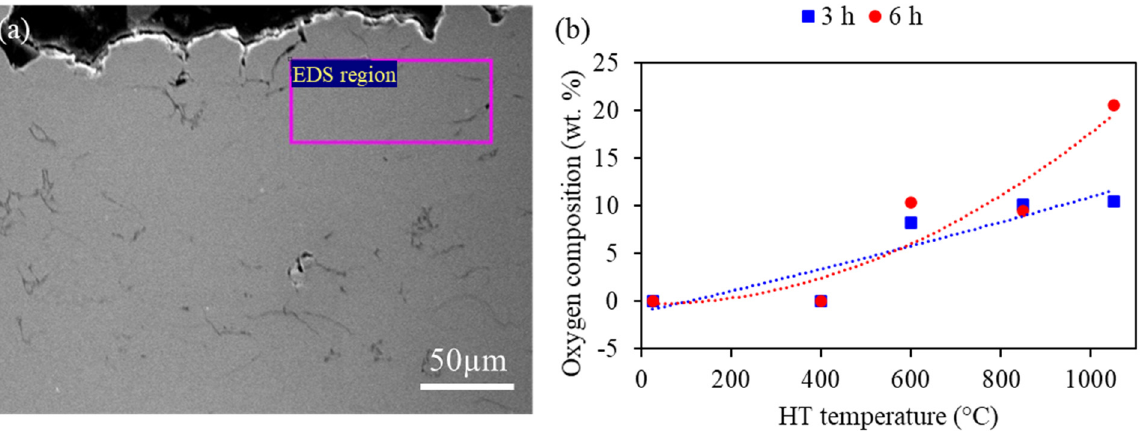
Figure 7. ( a ) SEM micrographs with EDS scanned region for 850-6 sample (representative sample), and ( b ) EDS oxygen composition of coating for different heat treatment temperatures and durations.